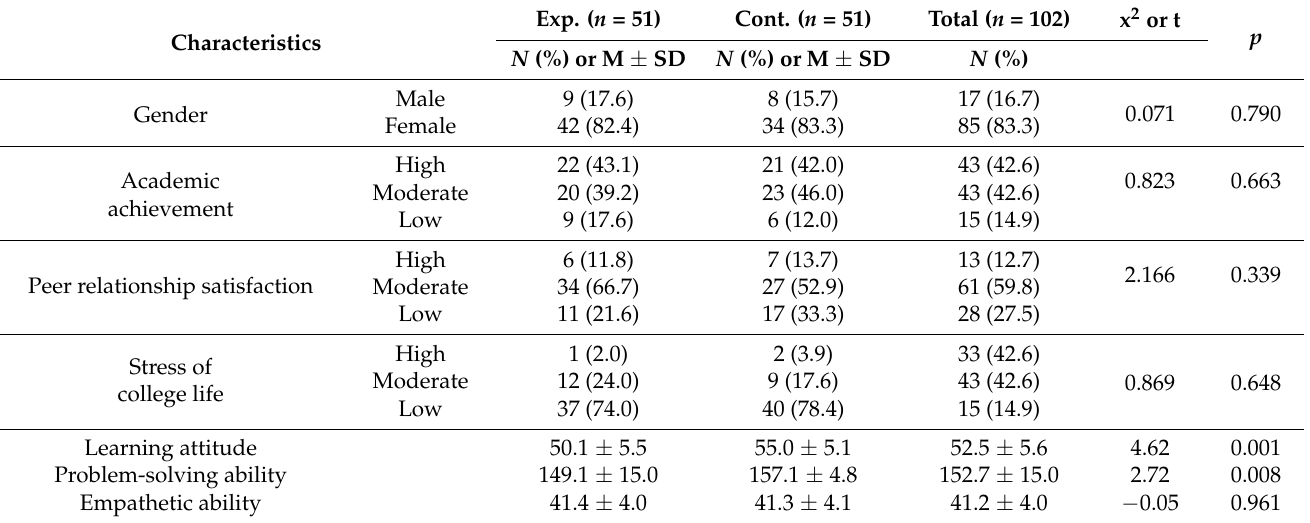
Table 1. Participants’ characteristics and study variables ( N =